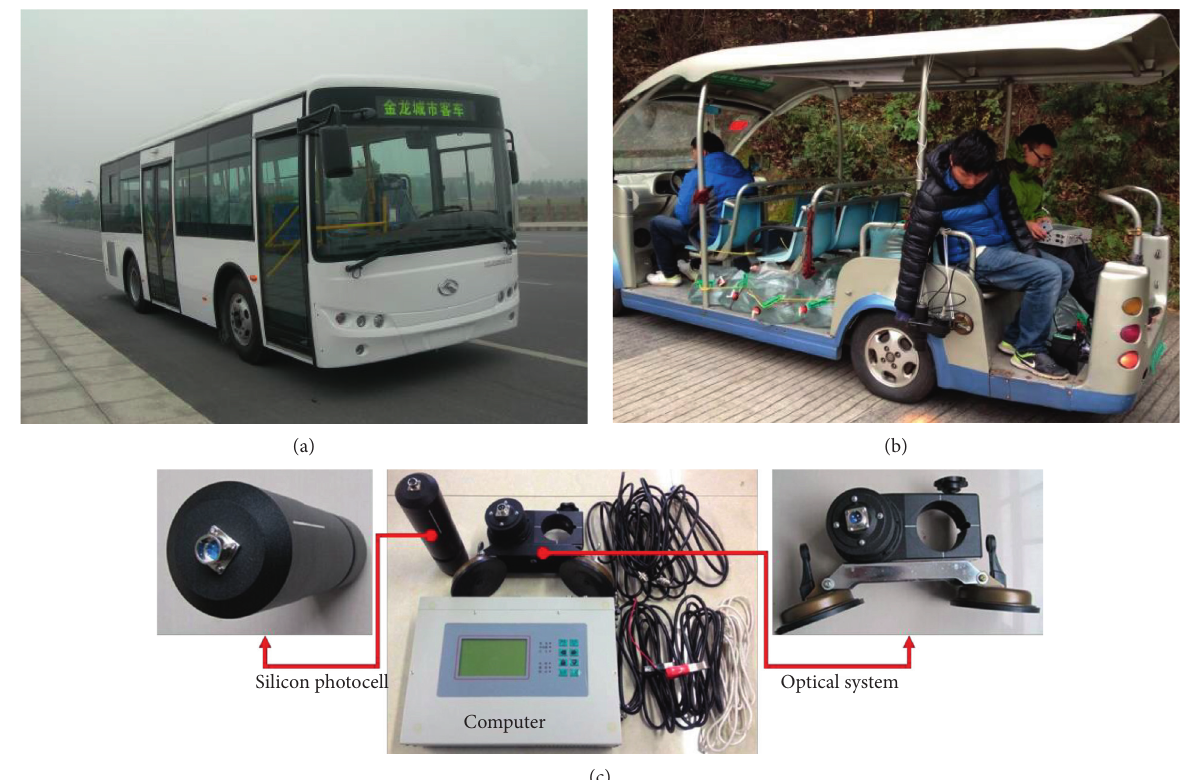
Figure 5: Equipment used in this experiment. (a) Jinlong XMQ6801G. (b) Wuling WLQ2110. (c) Photoelectric velocity sensor.